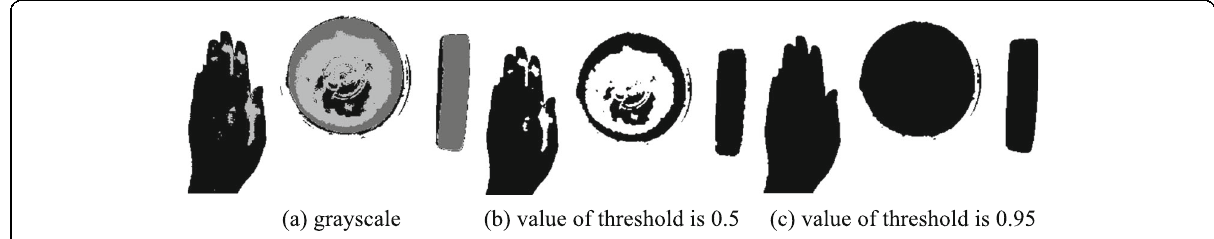
Fig. 12 Effects of threshold. a Grayscale. b Value of threshold is 0.5. c Value of threshold is 0.95